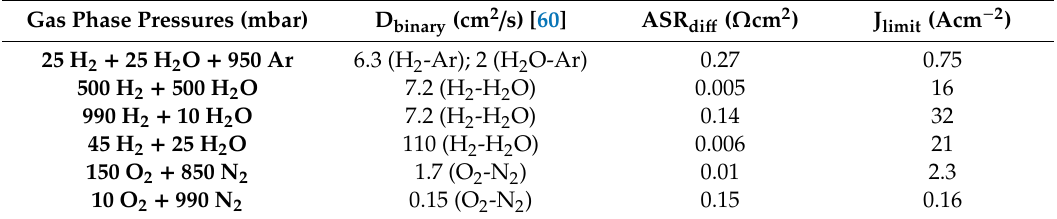
Table 1. Binary di ff usion coe ffi cients and di ff usion ASR for 1-mm porous support with 40% porosity and tortuosity factor 2 at 750 ◦